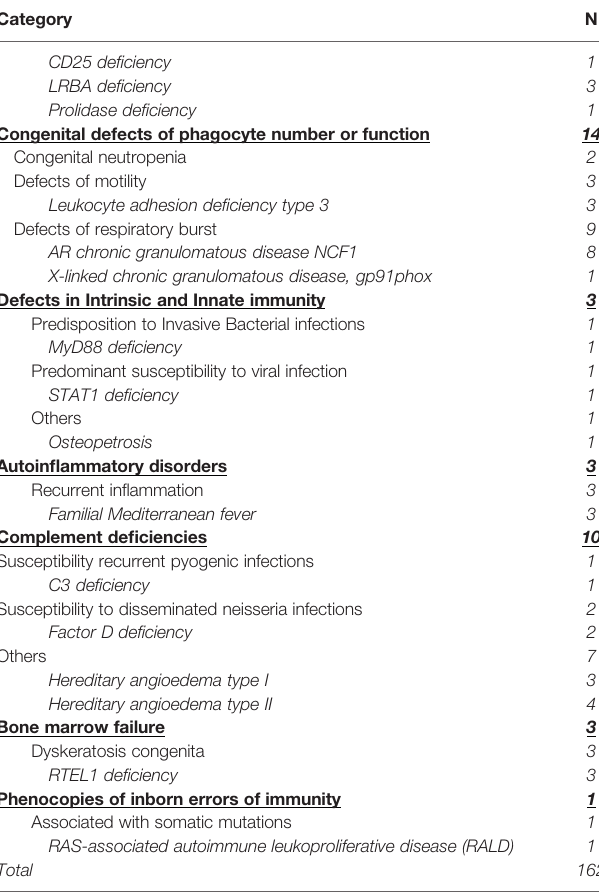
TABLE 2 | Frequency of each IEI in 162 UAE